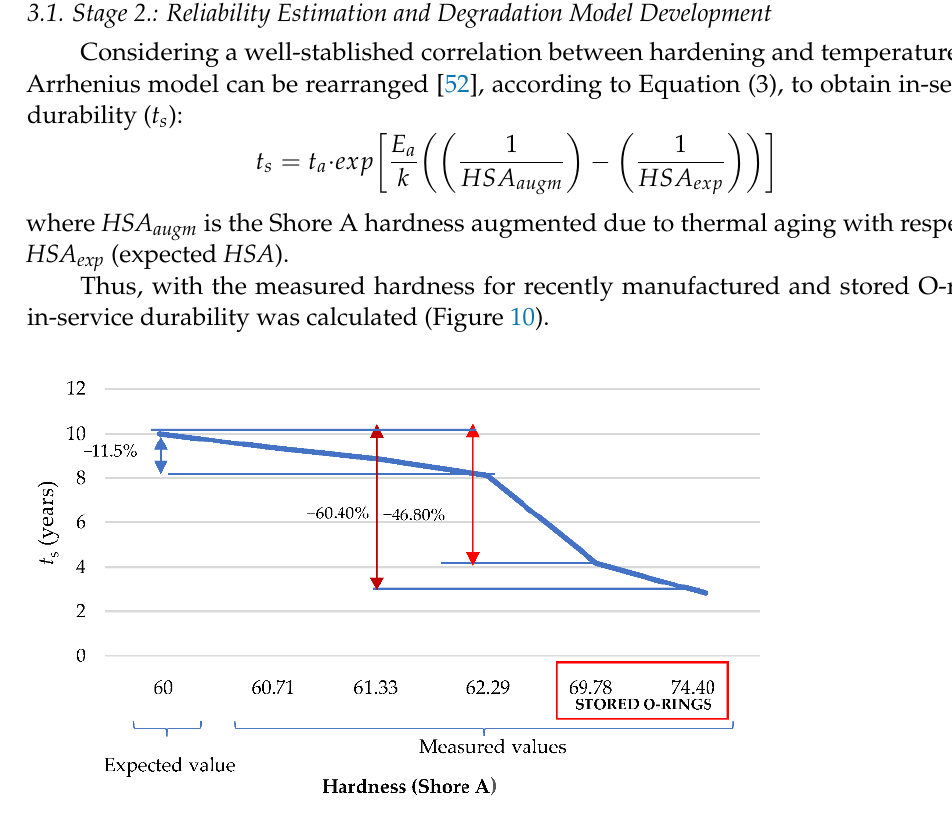
Figure 10. In-service durability as a function of the hardness. The storage conditions (and their associated hardening) have a direct effect on in- service durability, reducing it by up to 60.40%. Thus, time to integrity loss ( TTIL ), con- sidered as the time in operation where a Shore A hardness equals 65 (beginning of the embrittlement; according to Figure 9), can be calculated by using the Equation